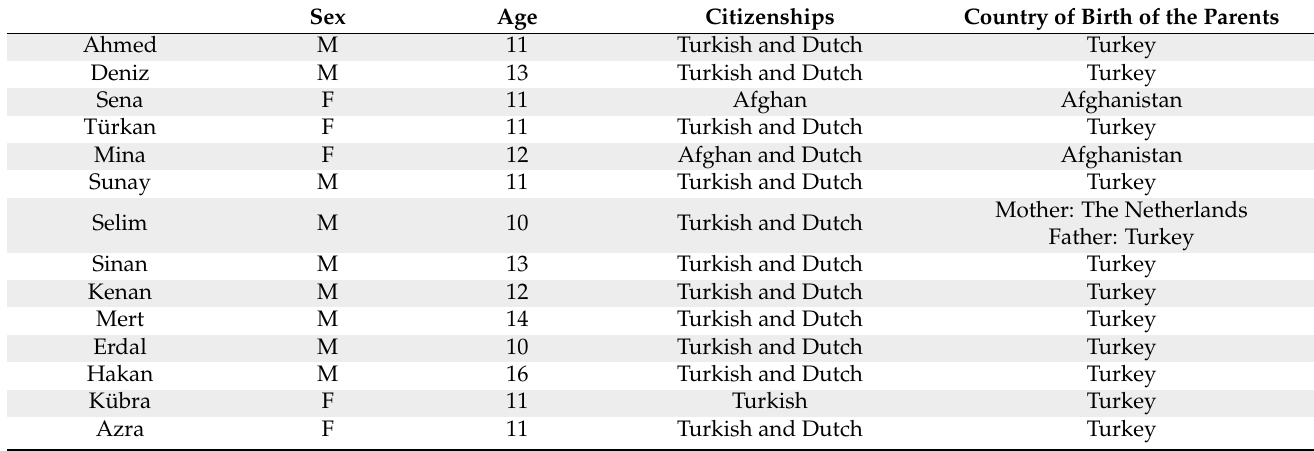
Table 1. Demographic characteristics of the students and their parents at the Diyanet